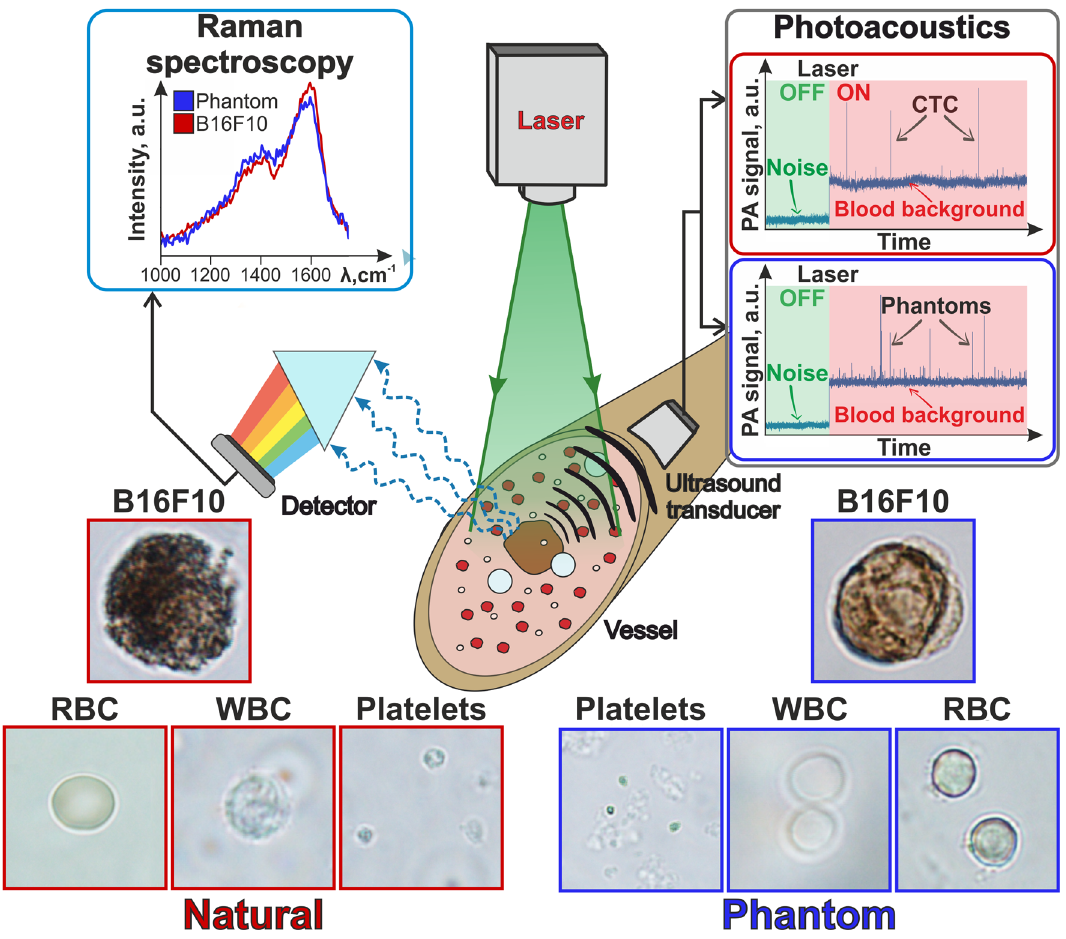
Figure 1. Principal scheme of in vivo flow cytometry. Left bottom—optical images of natural blood cells (red squares); right bottom—optical images of blood cell phantoms (blue squares); center—scheme of PA and Raman measurements (1064 nm laser for PA and 532 nm for Raman measurements); left top—Raman spectra of phantoms with melanin (blue) and B16F10 cells (red); right top—PA traces of blood with CTCs (red rectangle) and blood with phantoms (blue